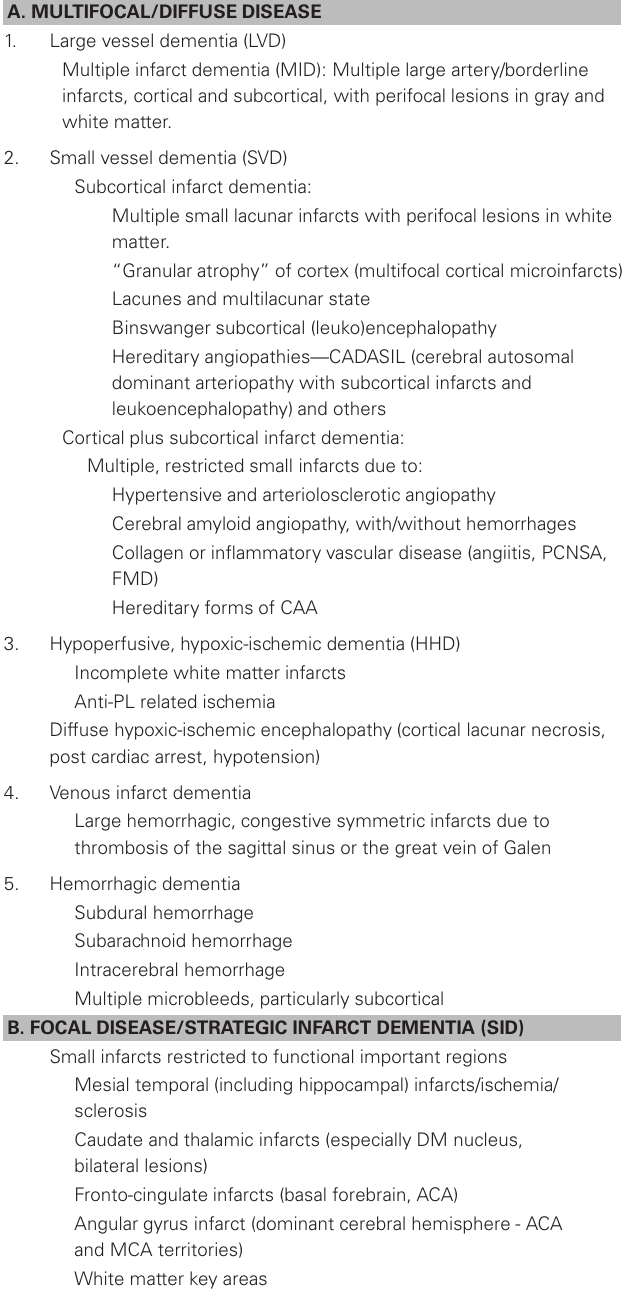
neuronal loss, gliosis, pallor, or more cystic lesions, found